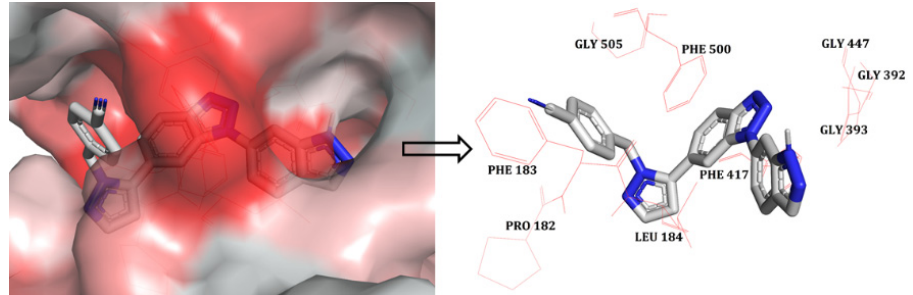
Figure 2. The most active compound, 48 , (shown in stick model) inside the hydrophobic pocket of CD73; The red-coloured region represents the most hydrophobic surface of the protein, and the white colour represents the least hydrophobic surface. Hydrophobic residues are indicated with red lines.